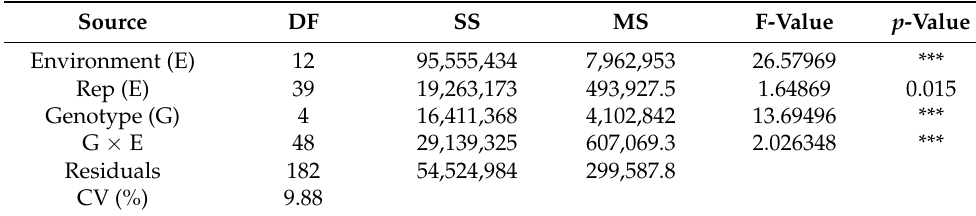
Table 4. Combined analysis of variance for pod yield in the study of 5 Virginia and runner peanut cultivars in 13 environments.